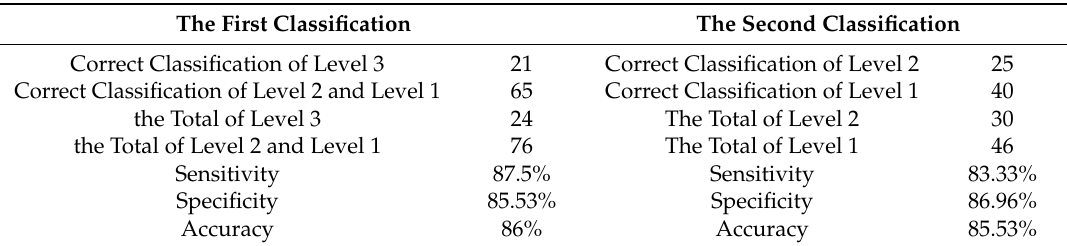
Table 3. The results of support vector machine (SVM) classification.